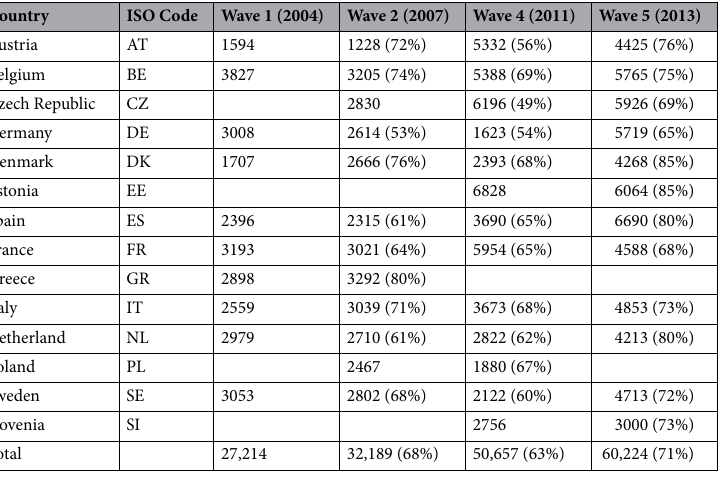
Table 1. Sample size by country and wave (in parenthesis, the retention rate from previous wave, including deceases). Source: Authors’ calculation using data from